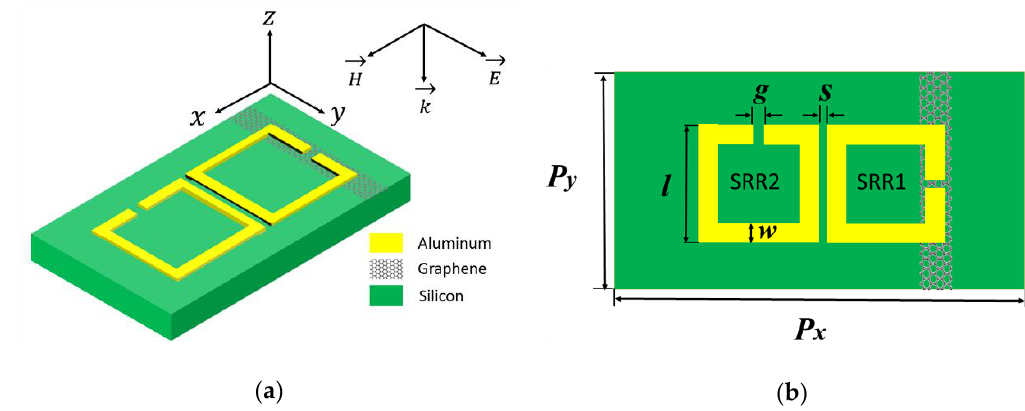
Figure 1. ( a ) Schematic representation of the tunable plasma-induced transparency (PIT) and the normal incident plane wave configuration. ( b ) Top view (from z axis) for the unit cell, the geometrical structure parameters are: Px = 100 µ m, Py = 50 µ m, l = 36 µ m, w = 6 µ m, s = 1 µ m, g = 2 µ m .